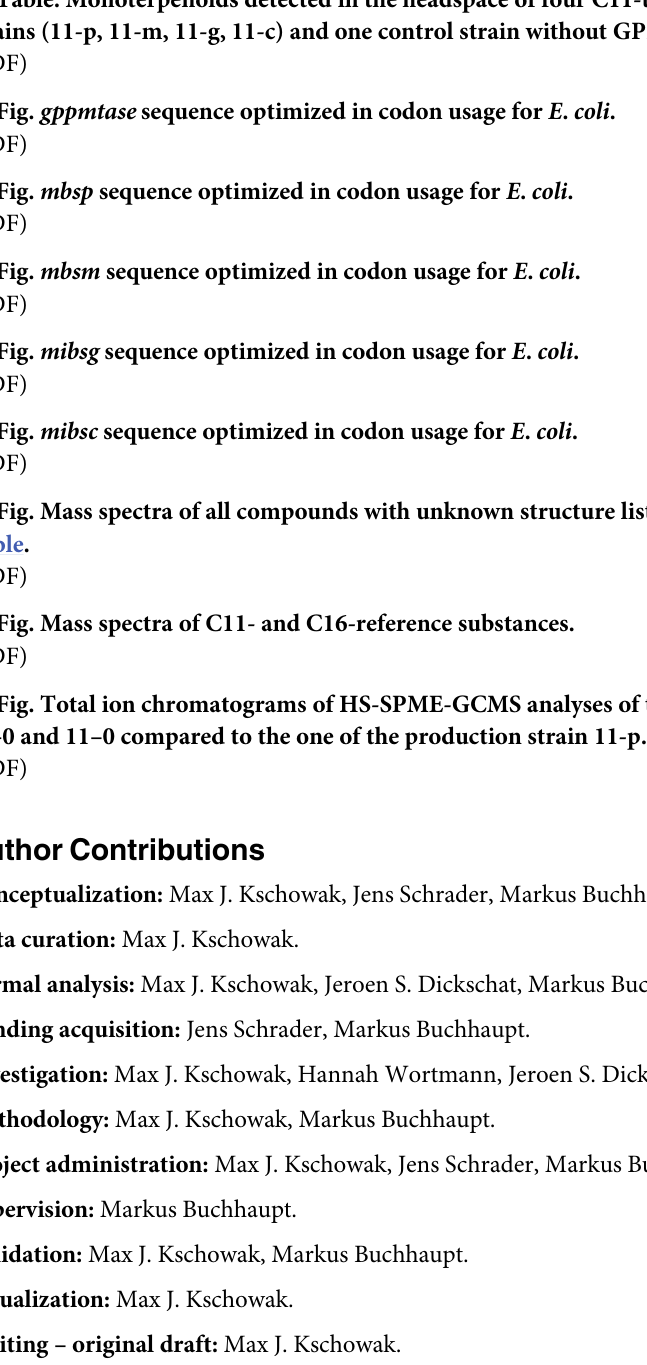
S2 Table. Monoterpenoids detected in the headspace of four C11-terpene production strains (11-p, 11-m, 11-g, 11-c) and one control strain without GPP-MTase and TS (10–0). (PDF) S1 Fig. gppmtase sequence optimized in codon usage for E . coli . (PDF) S2 Fig. mbsp sequence optimized in codon usage for E . coli . (PDF) S3 Fig. mbsm sequence optimized in codon usage for E . coli . (PDF) S4 Fig. mibsg sequence optimized in codon usage for E . coli . (PDF) S5 Fig. mibsc sequence optimized in codon usage for E . coli . (PDF) S6 Fig. Mass spectra of all compounds with unknown structure listed in Table 3 or S2 Table. (PDF) S7 Fig. Mass spectra of C11- and C16-reference substances. (PDF) S8 Fig. Total ion chromatograms of HS-SPME-GCMS analyses of the control strains 0–0, 10–0 and 11–0 compared to the one of the production strain 11-p.